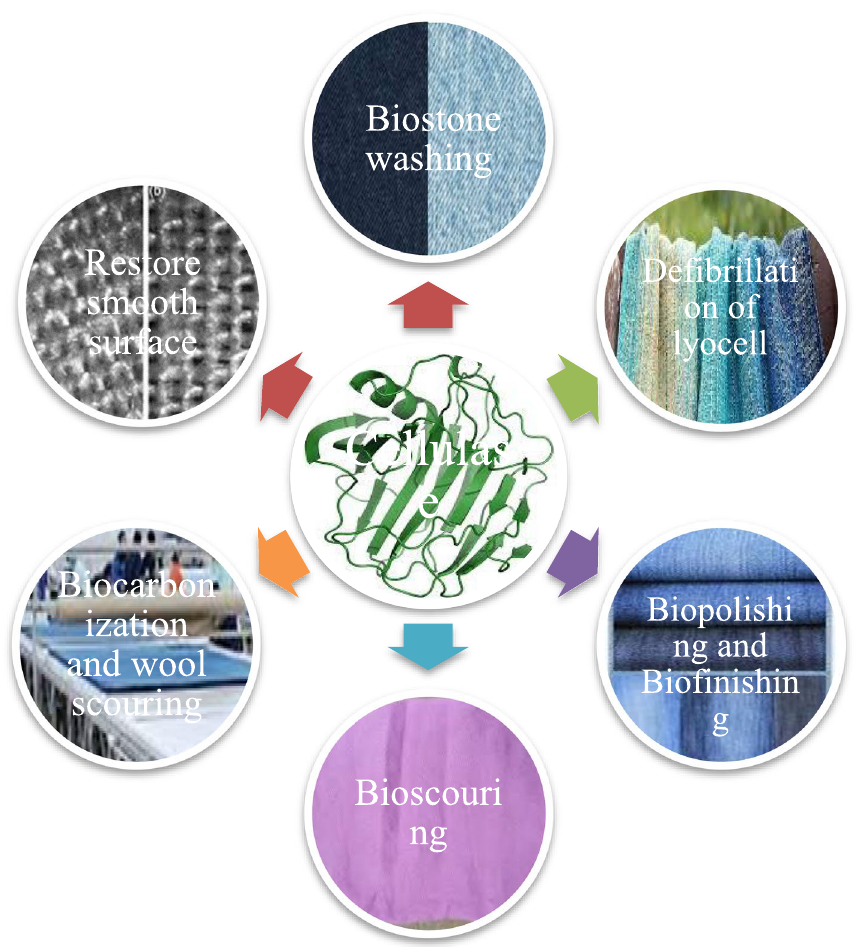
Fig. 3 Microbial cellulase application for textile industries (Biernat 2019; Jayasekara and Ratnayake